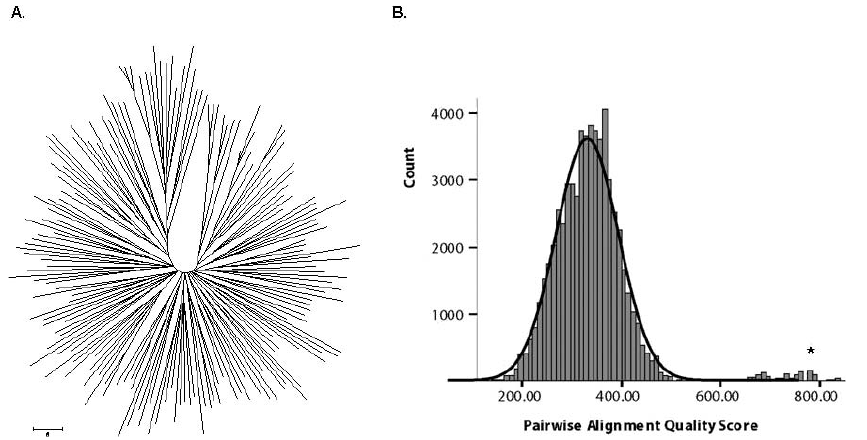
Figure 3. Diversity of Amele DBL a Sequences Relationships among the var gene sequences from Amele were defined by (A) phylogenetic analysis of Amele DBL a types. A multiple alignment of amino acid sequences was constructed in Clustal W [70] with parameters set at gap opening ¼ 5 and gap extension ¼ 0.05, for all translated DBL a types ( n ¼ 177 after removal of those with frame shifts) in the Amele population. A neighbor-joining tree was constructed in MEGA version 3.0 [71] for Amele types using the p-distance algorithm, pairwise alignment, and 1,000 bootstrapping repetitions. The consensus tree is shown. (B) Analysis of the pairwise alignment quality scores for Amele DBL a amino acid sequences. Here, the frequency distribution of scores is shown. Note the approximately Normal distribution of scores for the cluster of scores to the left, i.e., the dark line indicates maximum likelihood estimate for the Normal distribution. The asterisk indicates a cluster of pairs with high quality scores, which correspond to the shared sequences among isolates (types).